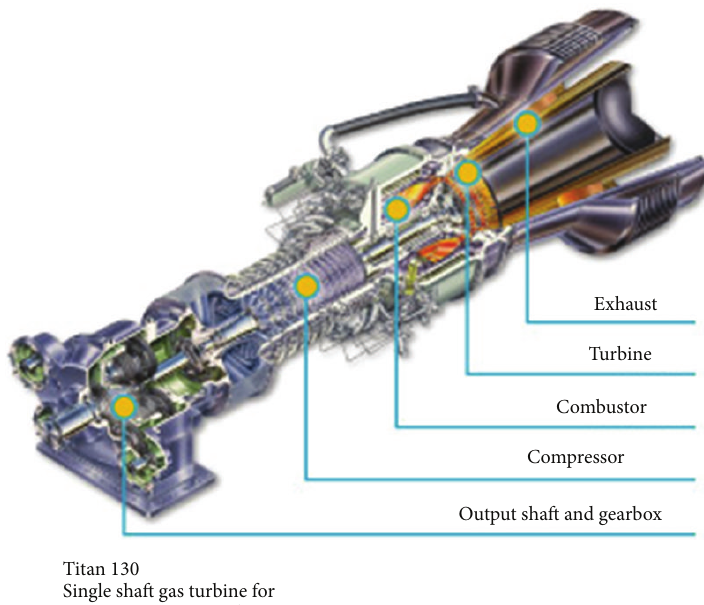
Figure 1: Prototype structure of a gas